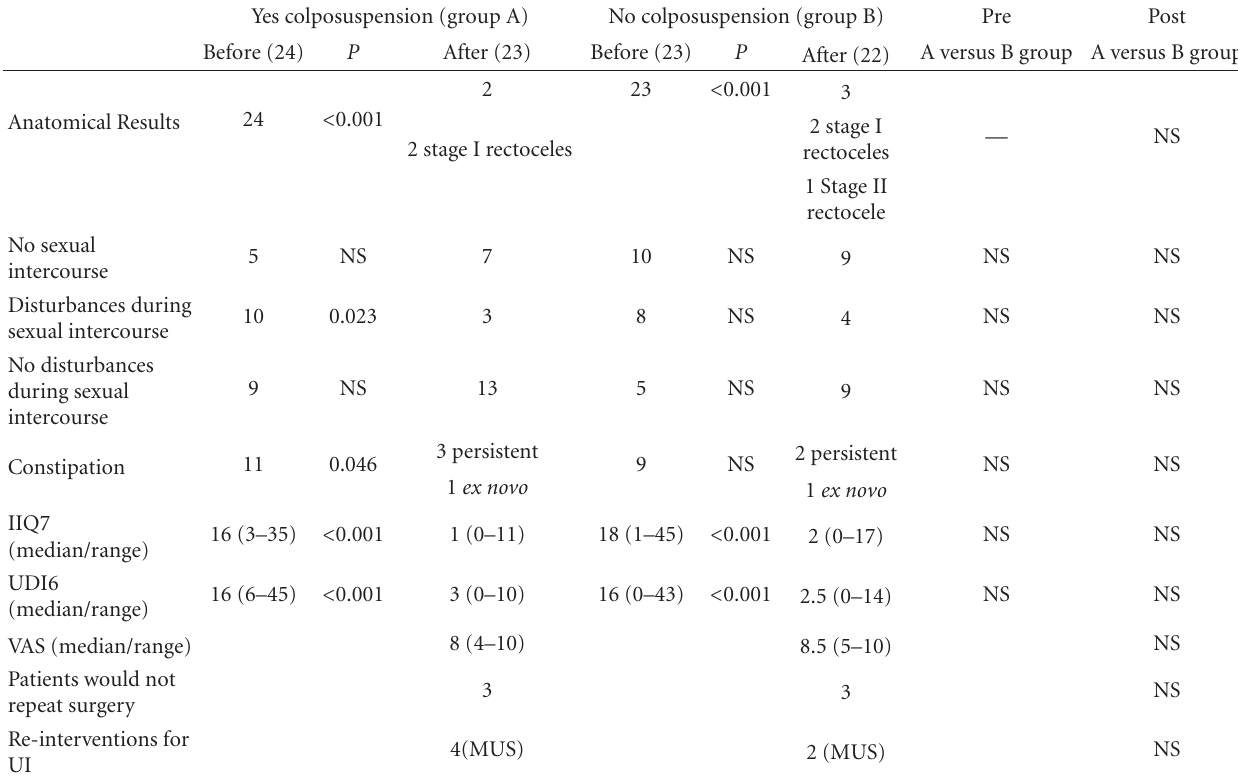
Table 3: Secondary outcome end-points in patients of group A and B. Outcomes after mid- and long-term